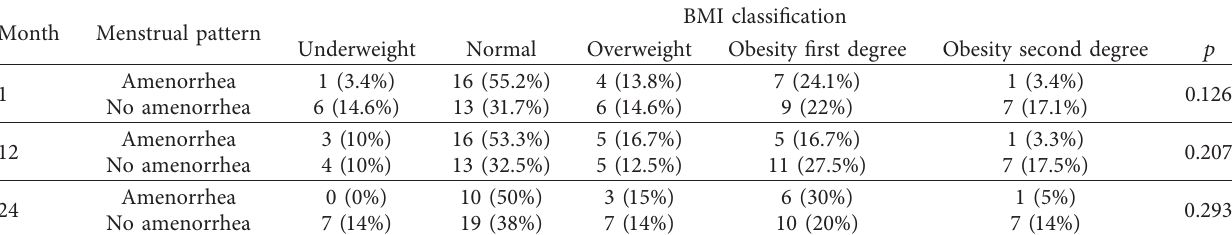
Table 7: The relationship between BMI and amenorrhea in two-rod users.